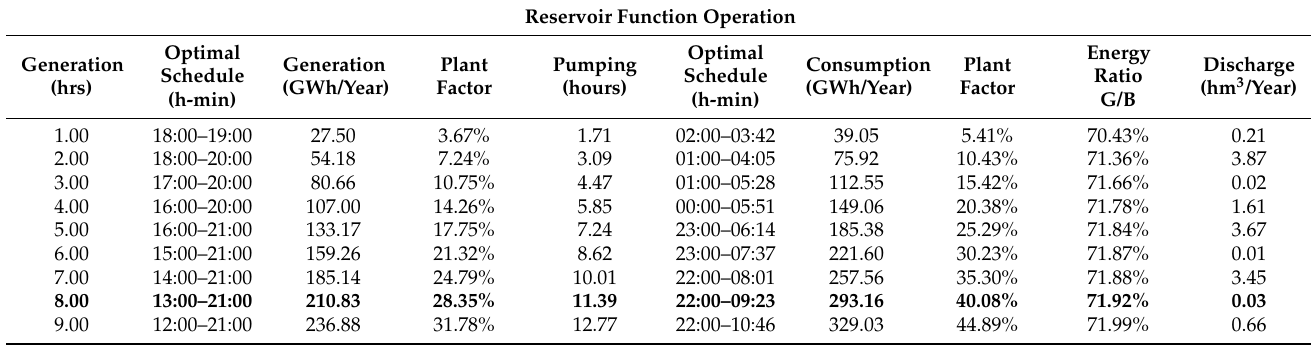
Table 8. Optimized function of reservoir operation.